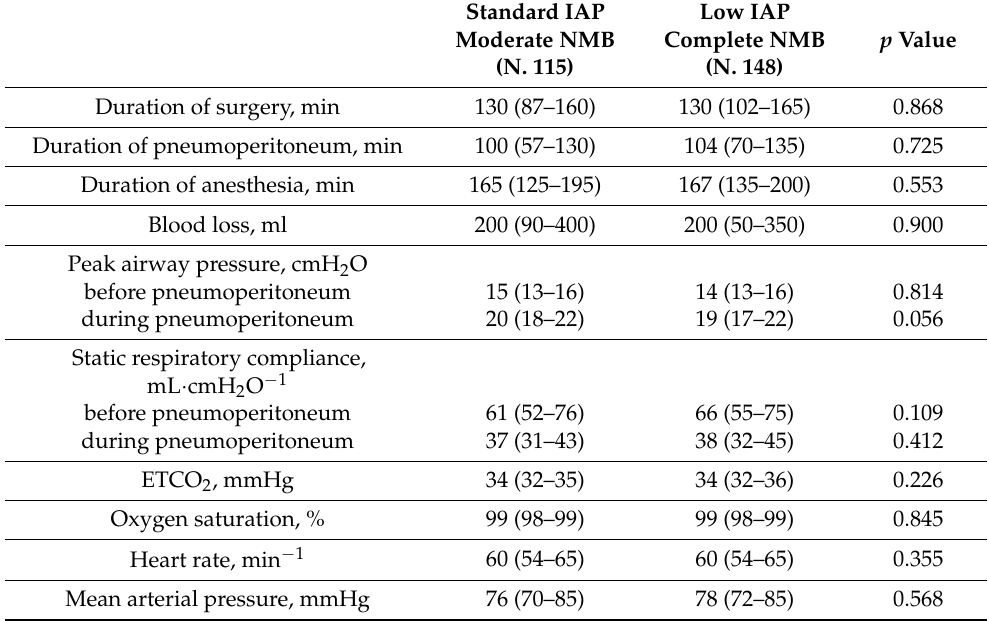
Table 3. Intra-operative